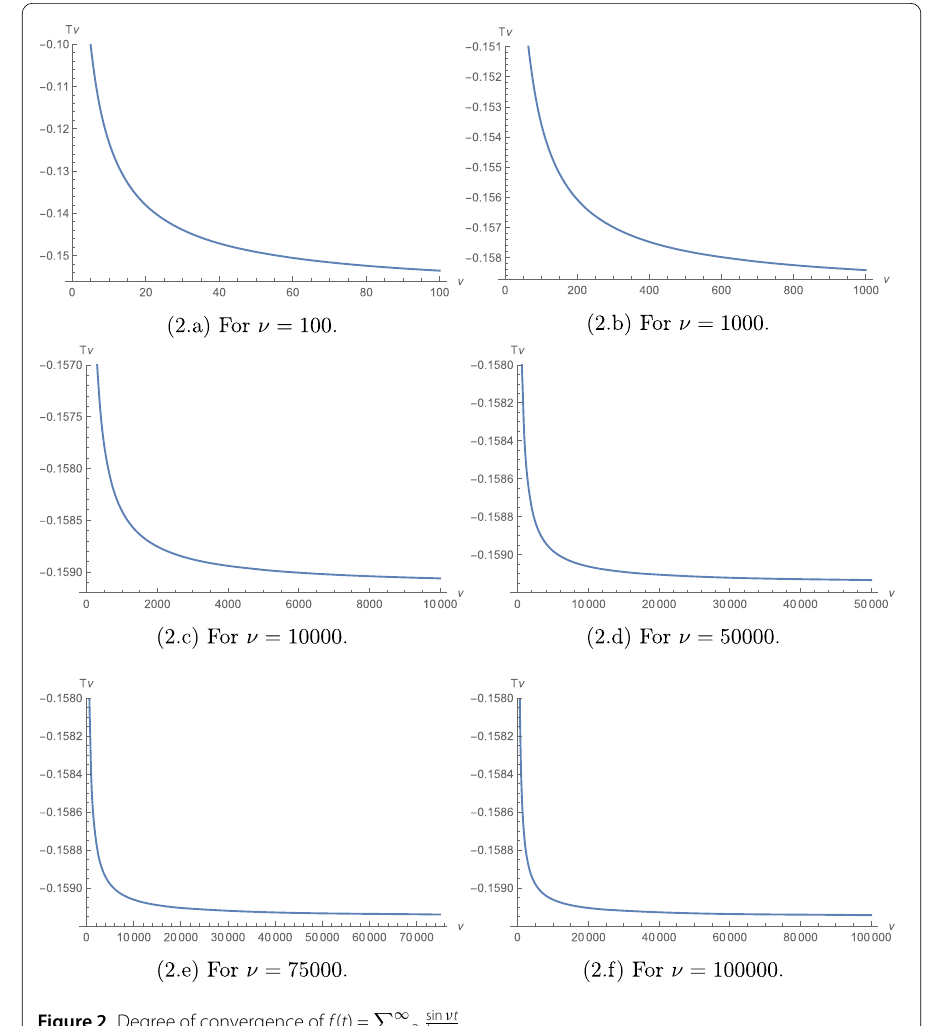
Figure 2 Degree of convergence of f ( t ) =